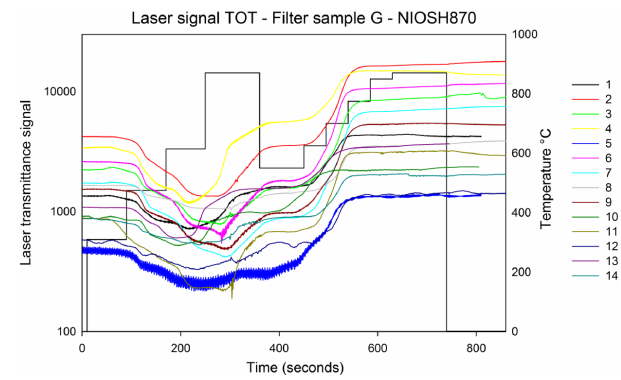
Figure 12. Laser transmittance signal during filter sample G analy- sis with the use of NIOSH870 thermal protocol for all